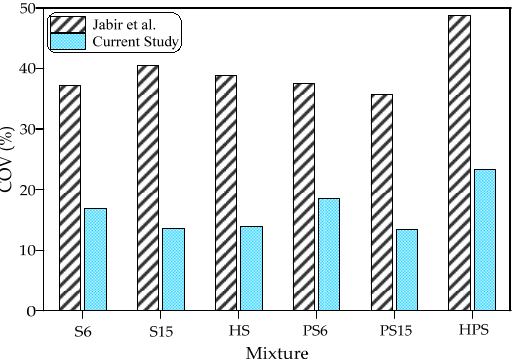
Figure 16. Comparison of cracking COV values of Jabir et al. [67] with those of the current study.